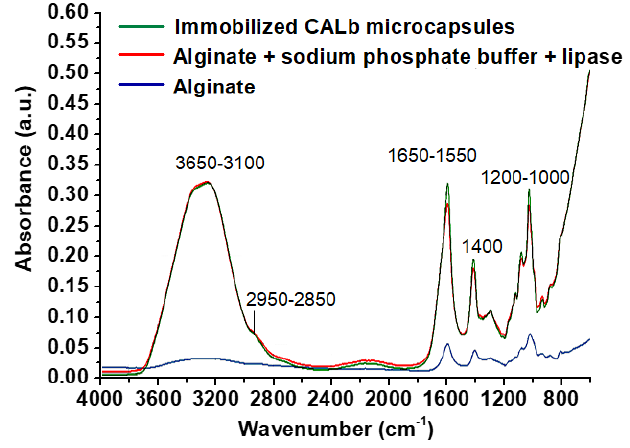
Figure 3. FTIR spectra of the Na alginate, mixture of alginate and sodium phosphate buffer, and immobilized CALb microcapsules.